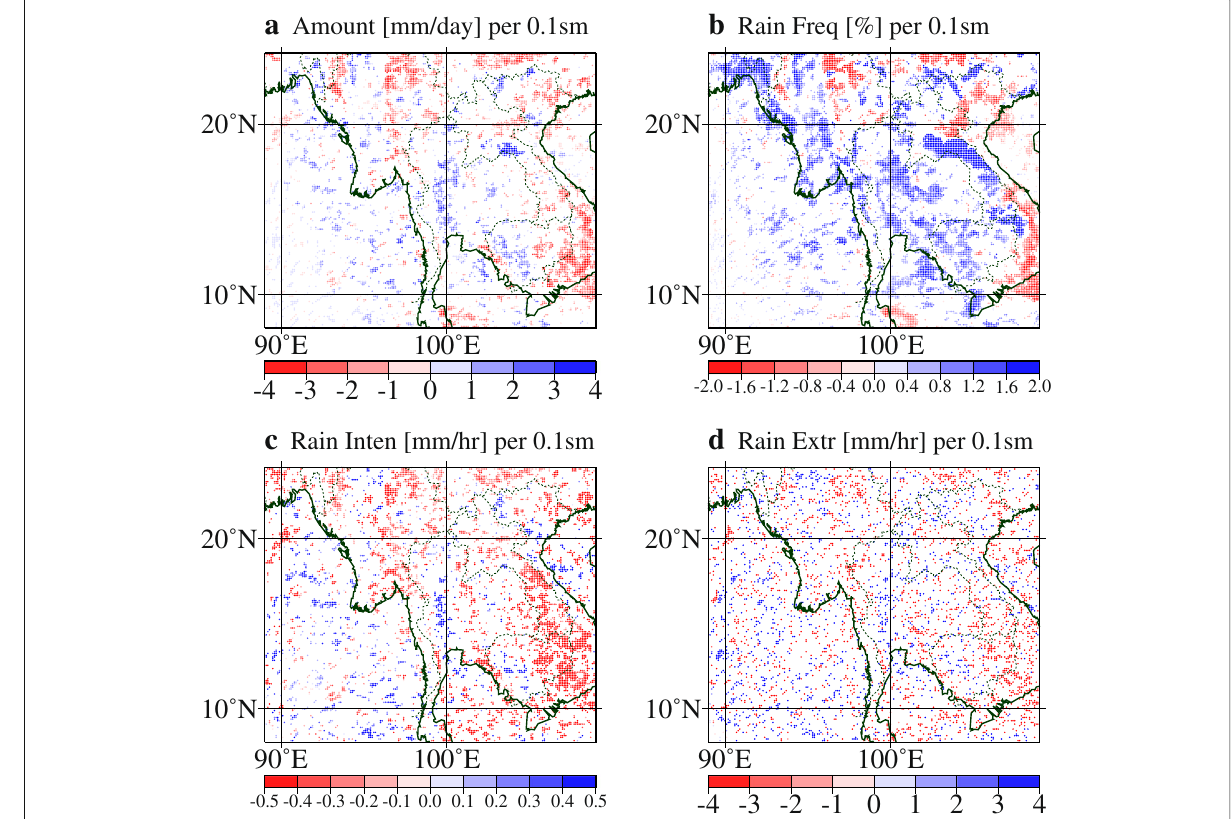
Fig. 3 Spatial map of prescribed soil moisture sensitivity (PSMsens (slope values)) of a rainfall amount, b rainfall frequency, c rainfall intensity, and d rainfall extremes as a function of the prescribed soil moisture value. All variables of rainfall characteristics were based on a 30-min time interval and 59-day data. We used the SM020, SM025, SM030, SM035, SM040, and SM045 experiments for the calculation of systematic sensitivity. The blue color indicates an increase in rainfall amount, rainfall frequency, rainfall intensity, and rainfall extremes with soil moistening. The units are mm day − 1 per 0.1 increase in soil moisture, % per 0.1 increase in soil moisture, mm h − 1 per 0.1 increase in soil moisture, and mm h − 1 per 0.1 increase in